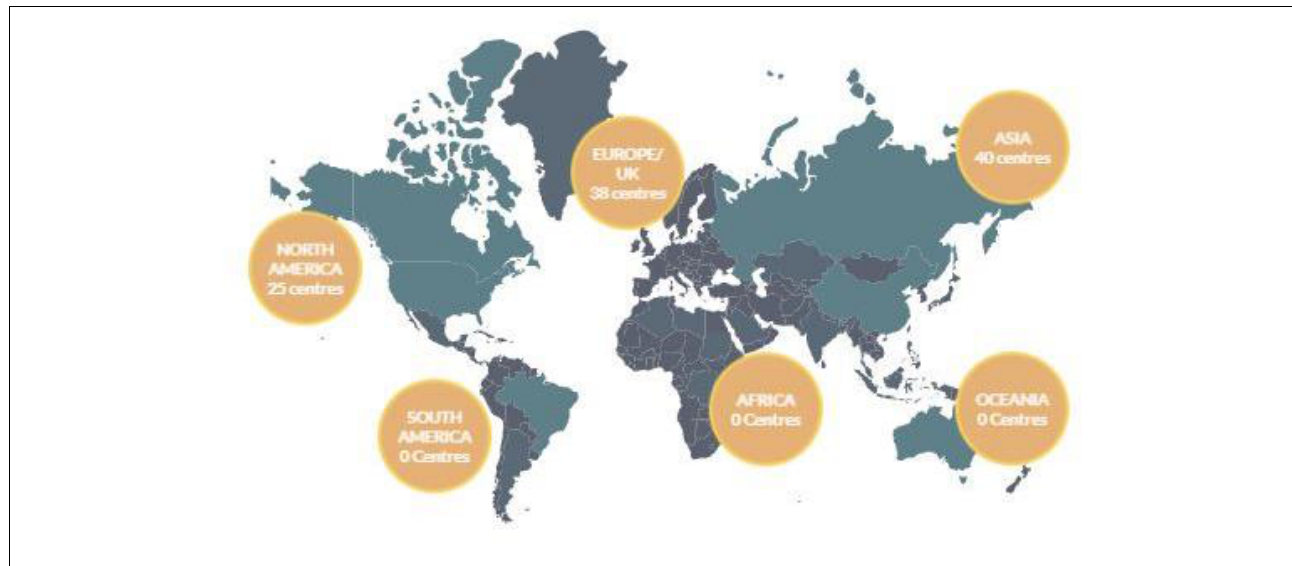
Figure 2. Particle therapy facilities in clinical operation as of October 2022.